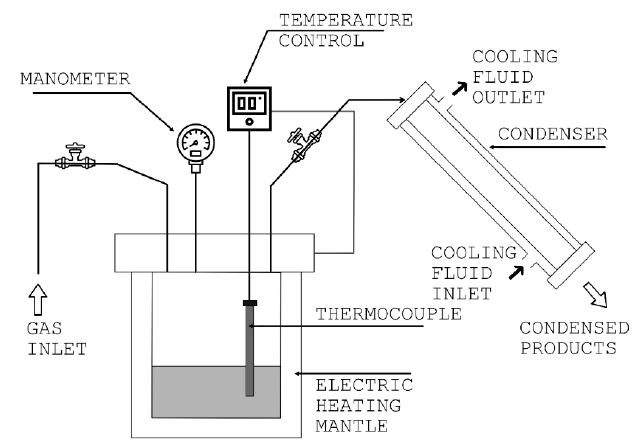
Figure 2. Depolymerization reaction system.